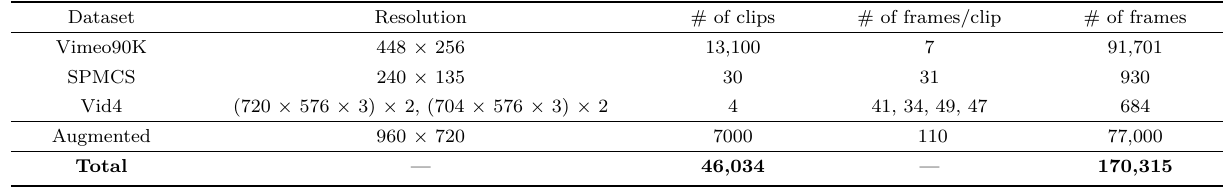
Table 1 Datasets used for training and